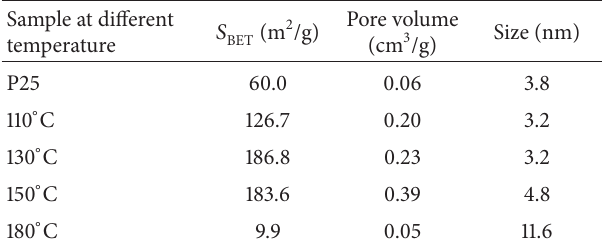
Table 1: BET analysis of as-prepared titanate nanotubes at different temperature and after 24 h.